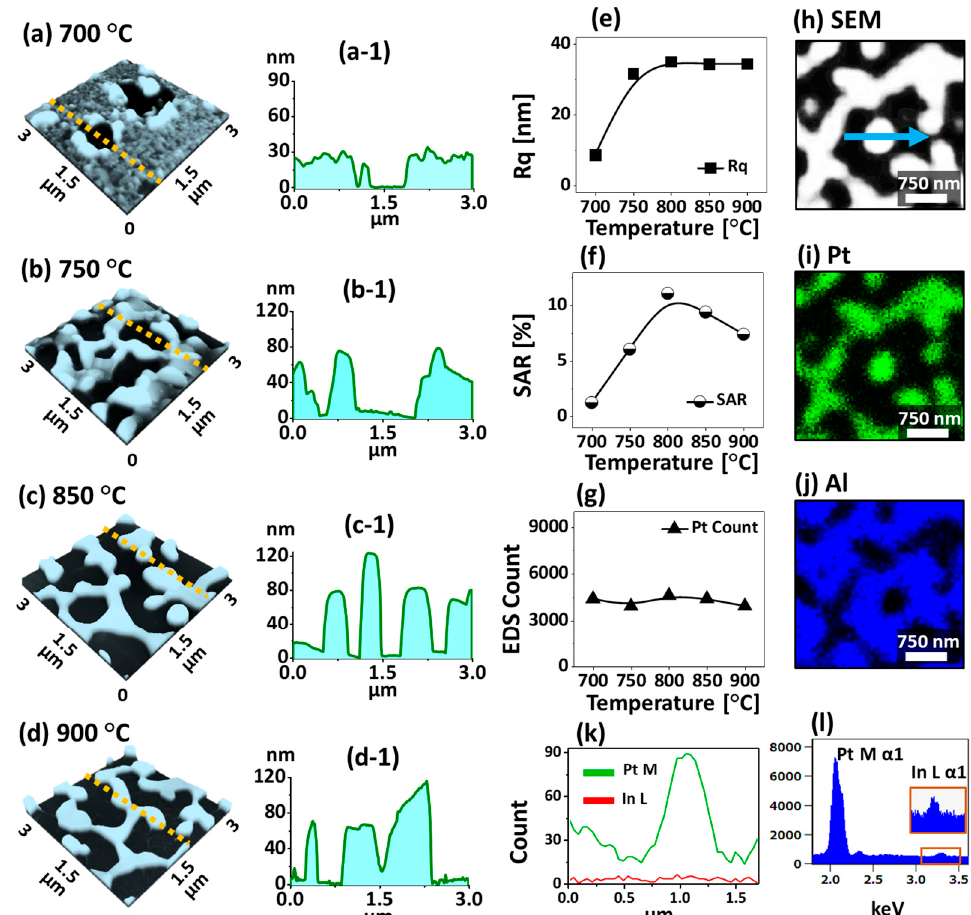
Figure 3. Evolution of various morphologies of Pt nanostructures with the In 30 nm / Pt 30 nm bilayers by annealing between 700 and 900 ◦ C for 450 s. ( a )–( d ) AFM side-views (3 × 3 µ m 2 ). ( a-1 )–( d-1 ) Cross-sectional line-profiles from ( a )–( d ). ( e )–( g ) Summary plots of Rq, SAR and energy dispersive x-ray spectroscopy (EDS) Pt count of the Pt nanostructures on sapphire. ( h ) SEM image (3 × 3 µ m 2 ) of sample annealed at 900 ◦ C for 450 s. ( i )–( j ) Corresponding Pt and Al phase maps. ( k ) Elemental line-profile of Pt NP marked with an arrow in ( h ). ( l ) EDS spectrum of Pt nanostructures.